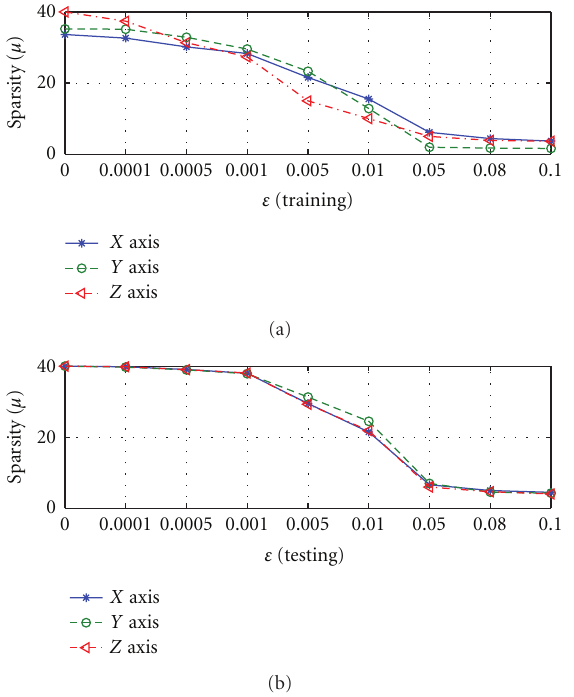
Figure 13: Sparsity ( μ ) of surface representation changes with dif- ferent δ on three axis: (a) is for training set; (b) is for testing set.